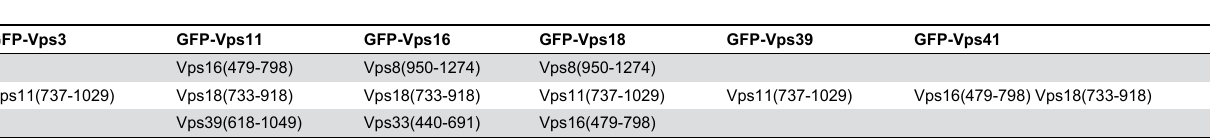
Table 1. Segments of Vps subunits mediating assembly of CORVET and HOPS